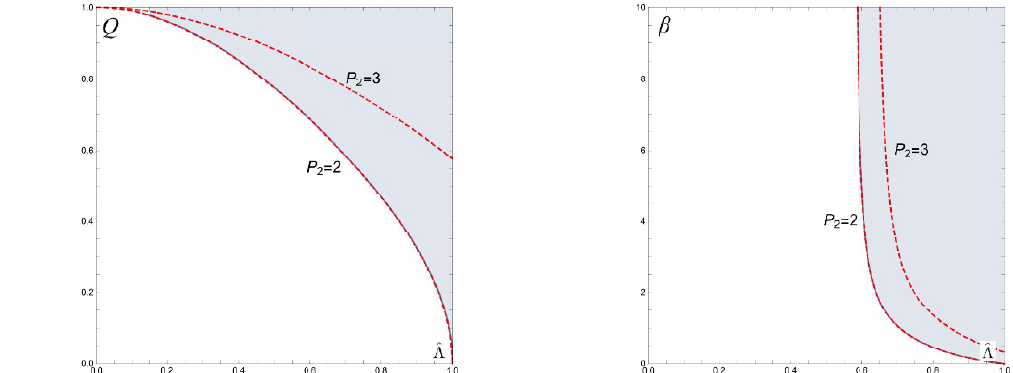
Figure 2 . In the parameter spaces, the unstable regions are in blue for the RN-dS (left) and GB-dS (right) black holes from the non-linear evolution, the threshold is along the line P 2 = 2. The horizontal axis is ^(cid:3) and the vertical axis is Q (left) or (cid:12) (right). The red lines represent the conditions that the linear perturbation is static [21,